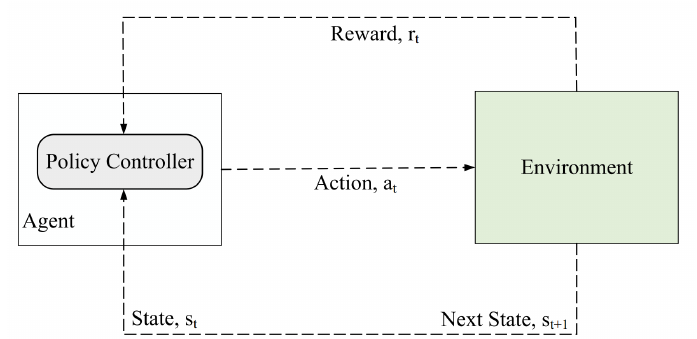
Figure 2. Reinforcement learning